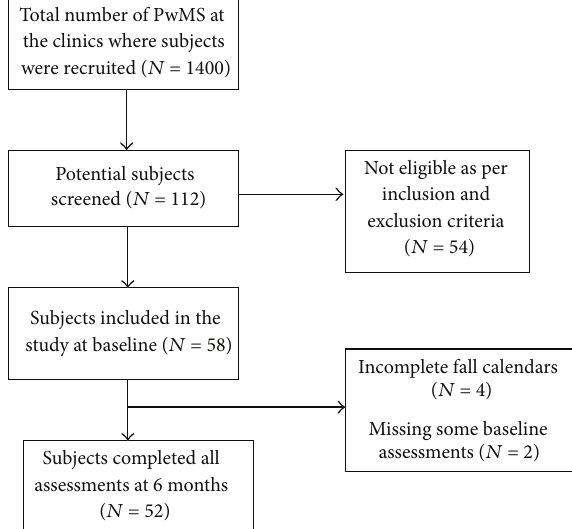
Figure 1: Participant flow